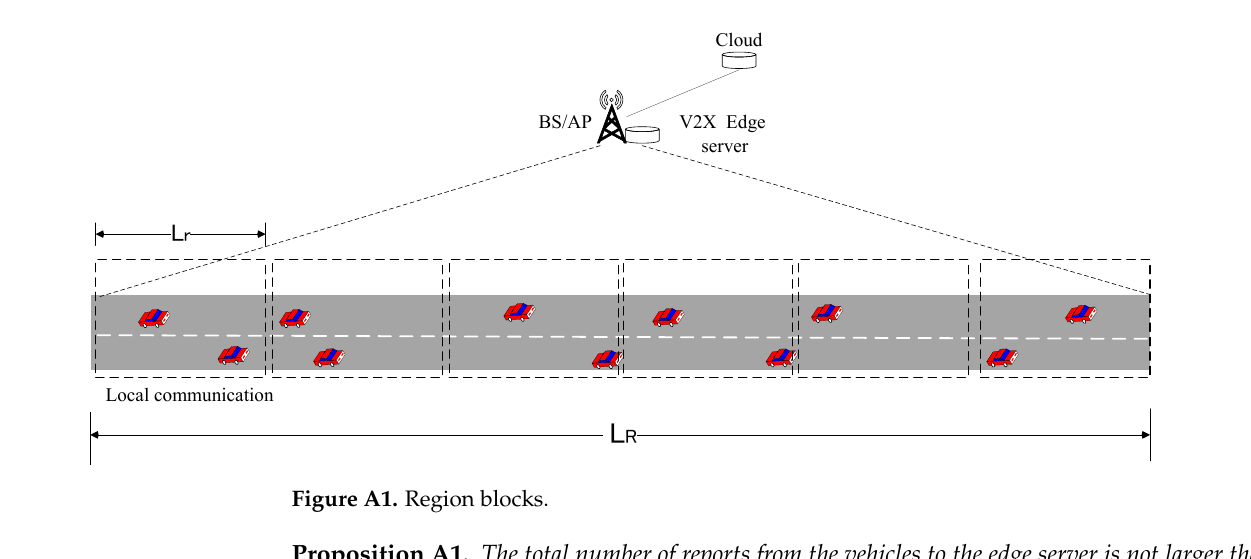
Figure A1. Region